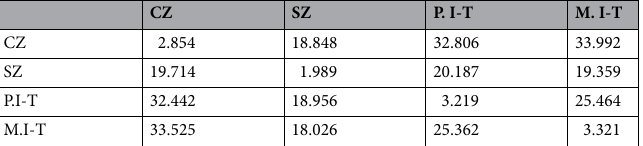
Table 5. Squared distance among studied populations of T. graeca in Central Iran, using discriminant function analysis. Population codes are given in Fig. 5.